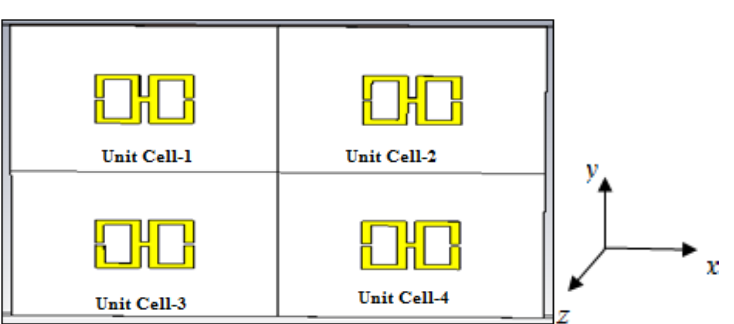
Figure 15. The 2 × 2 H-shaped unit